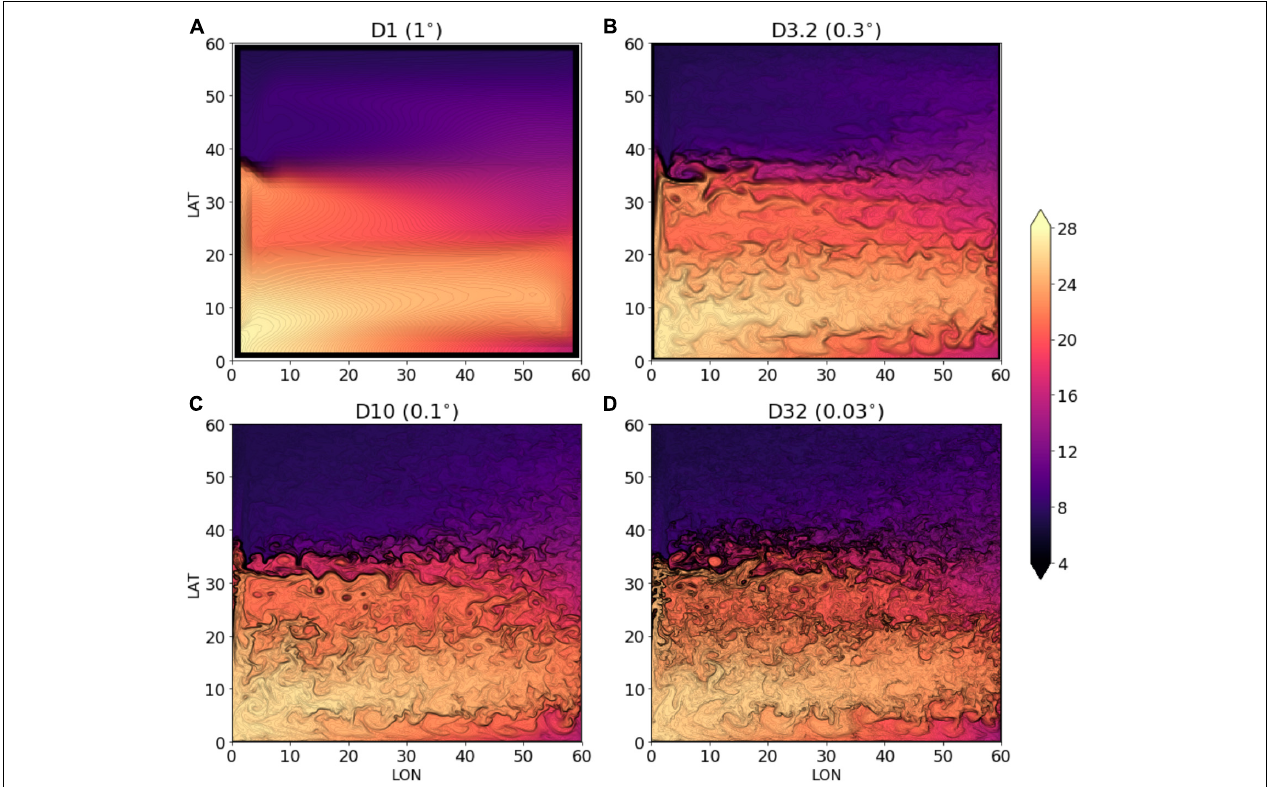
FIGURE 3 | Snapshots of sea surface temperature (in ◦ C) in experiments (A) D1, (B) D3.2, (C) D10, and (D) D32. Black contours of 0.1 ◦ C interval are plotted to delineate the